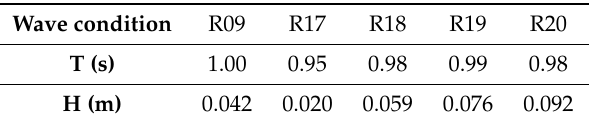
Table 3. Regular waves used for free motion in regular waves experiments in order to analyse the influence of increasing wave